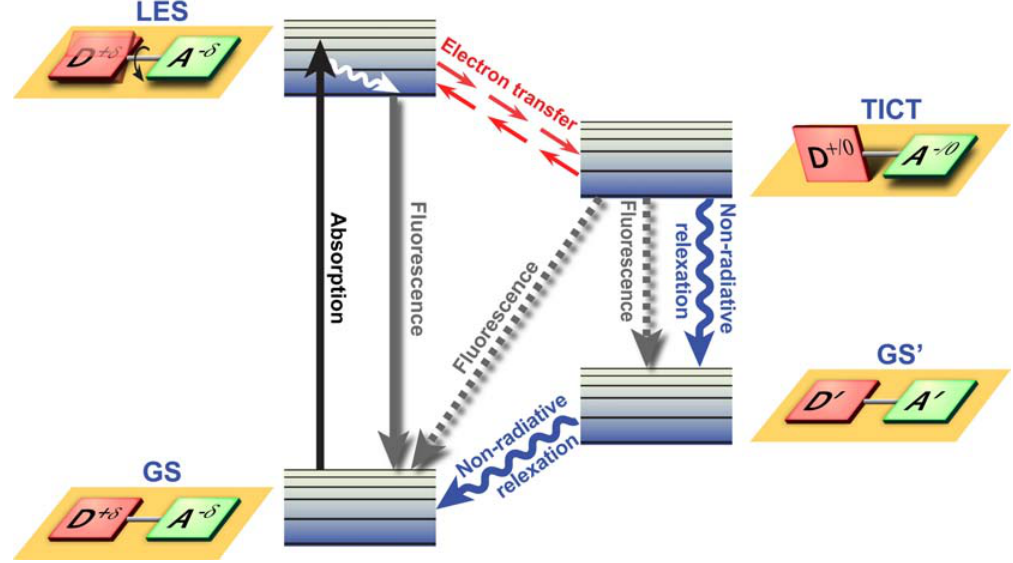
Figure 3. Twisted Intramolecular Charge Transfer (TICT) dynamics. Upon excitation from the ground state (GS), the locally excited state (LES) equilibrates rapidly with the TICT state after fast electron transfer. The TICT state is energetically lower and relaxation from the TICT state occurs either radiatively or non-radiatively to a thermally hot ground state (GS’) which after dissipation of heat becomes the GS. Alternatively, excess energy is dissipated via direct radiative relaxation to the GS. The exact pathway for energy dissipation depends strongly on the polarity of the